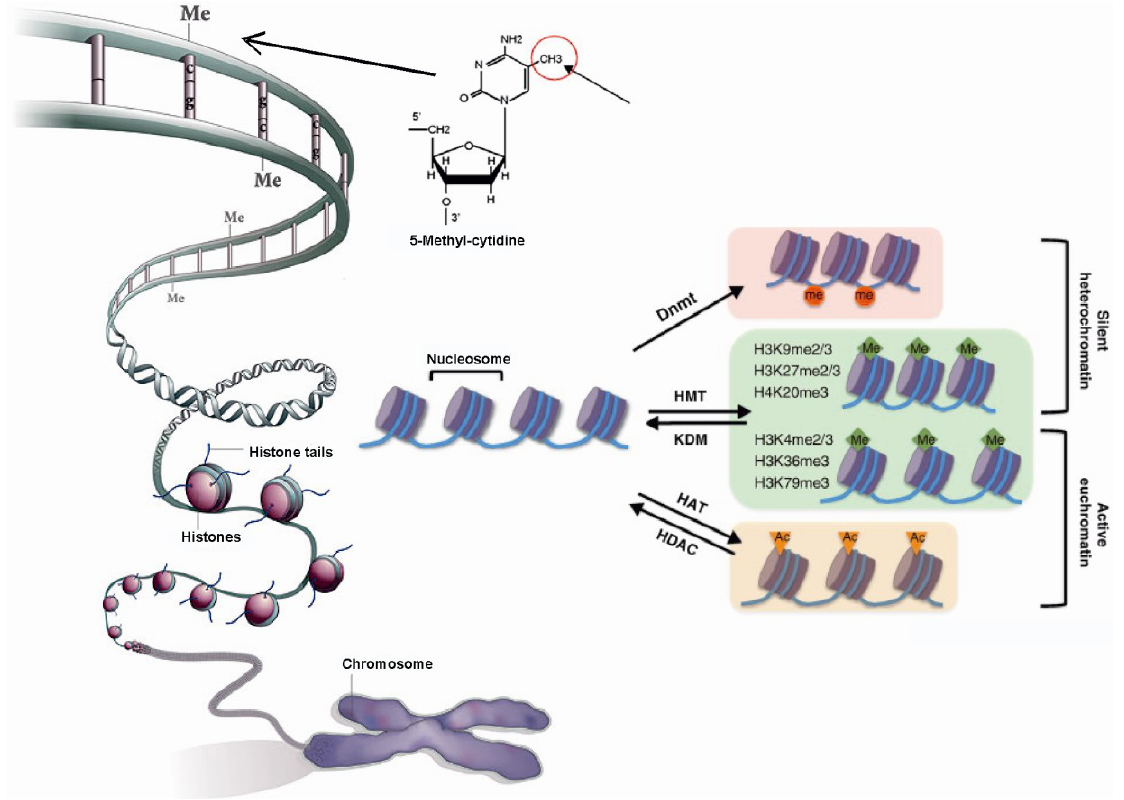
Figure 1. Role of epigenetic modification in chromatin